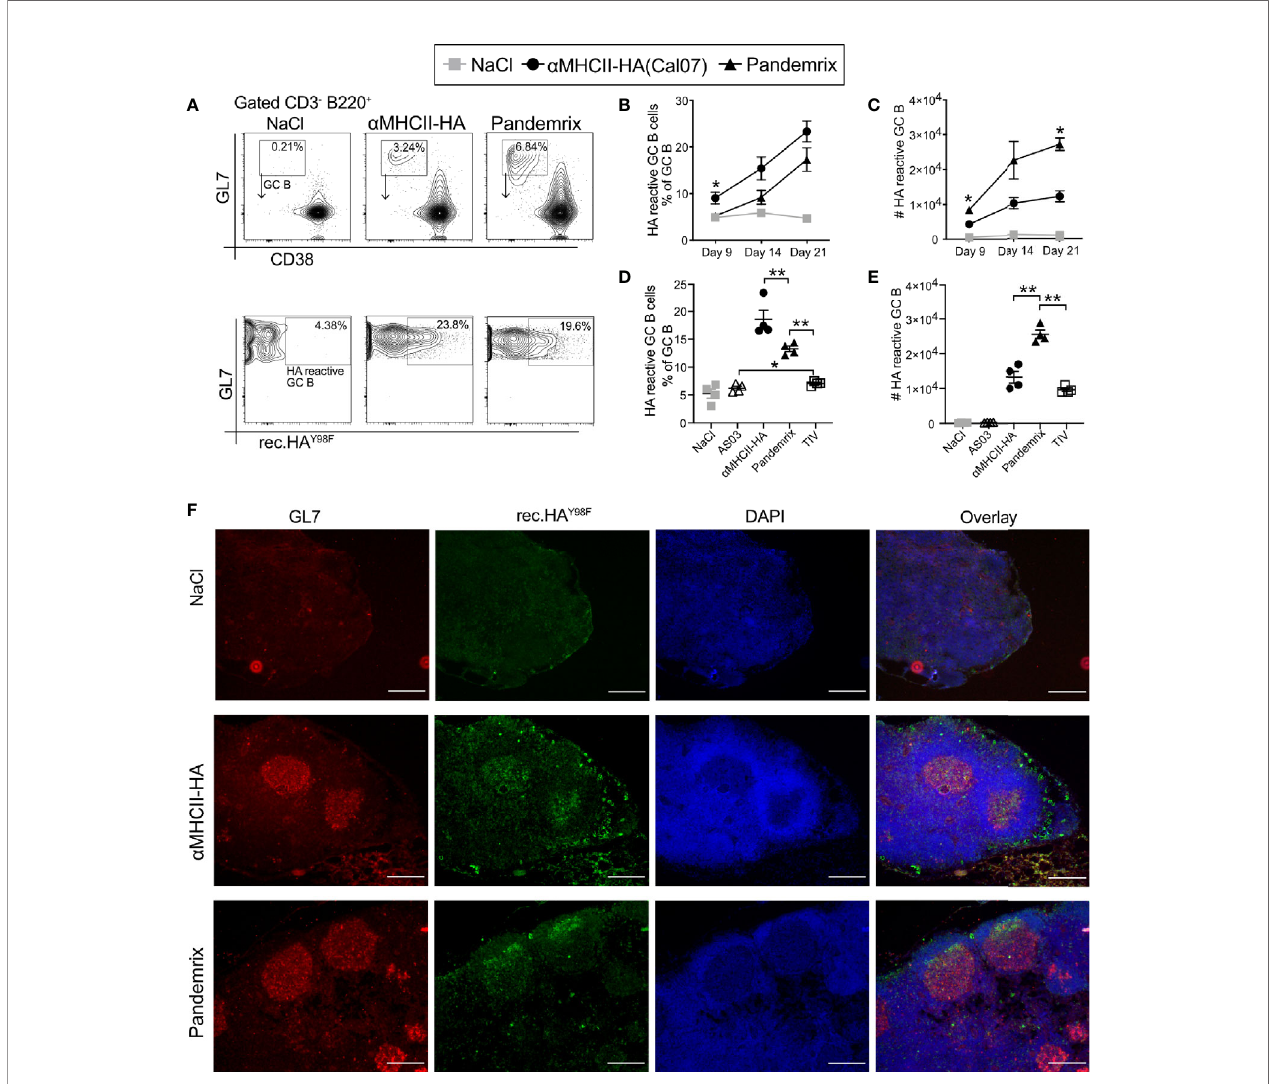
FIGURE 4 | Germinal center response and early formation of plasma cells after vaccination. Mice (n=4/group) were vaccinated i.m. with the indicated vaccines. (A – E) Draining lymph nodes (iliac) were harvested and examined for B cells (CD3 - B220 + ), GC markers (GL7 + CD38 lo ), and binding to a recombinant HA probe by fl ow cytometry. (A) Gating strategy. Representative fl ow charts are shown. (B) Fraction of HA reactive B cells with a GC phenotype on the indicated time points. (C) Absolute numbers of HA reactive GC B cells from draining LNs at the indicated time points. (D, E) In a new experiment, the GC response was investigated at 21 days post vaccination. (D) Fraction of HA reactive B cells with a GC phenotype. (E) Absolute numbers of HA reactive GC B cells. (F) Cryosections of draining lymph nodes harvested 21 days after vaccinations, and stained with GL7 (red), rHA Y98F (green), and DAPI (blue). Scale bar is 200µm. Data shown are mean ± SEM, *P < 0.05, **P < 0.01